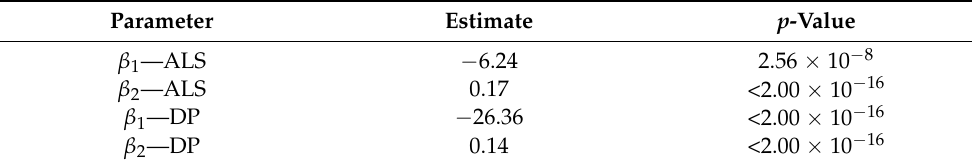
Table 3. Estimated model parameters according to Equation (3) based on ALS and DP data.